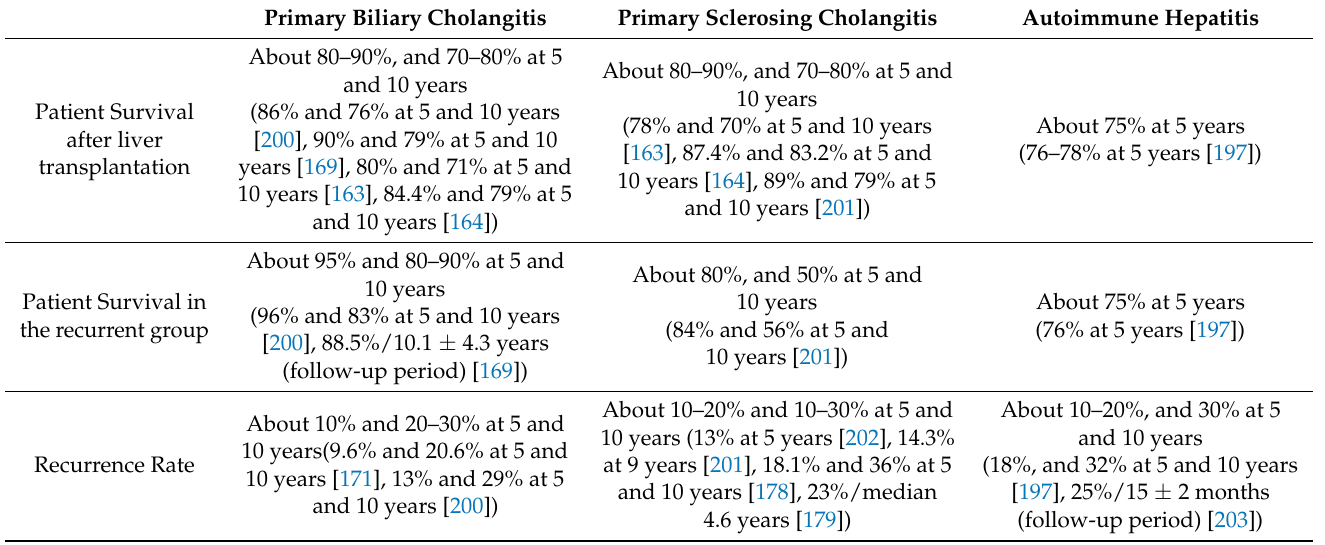
Table 4. Overall graft and patient survival and other key information in autoimmune liver diseases after liver transplanta-